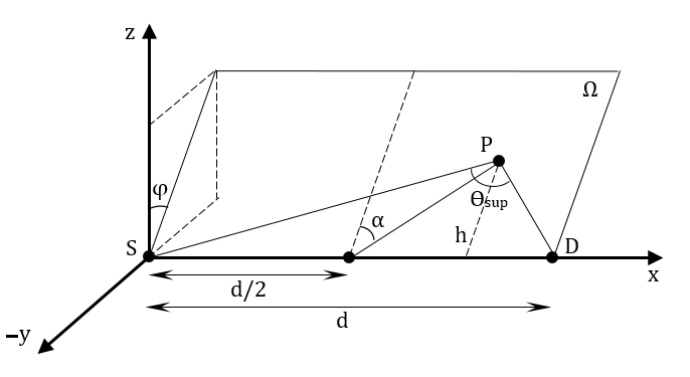
Figure A1. Coordinate system used to express each point P as a function of the angles α , φ and θ sup .